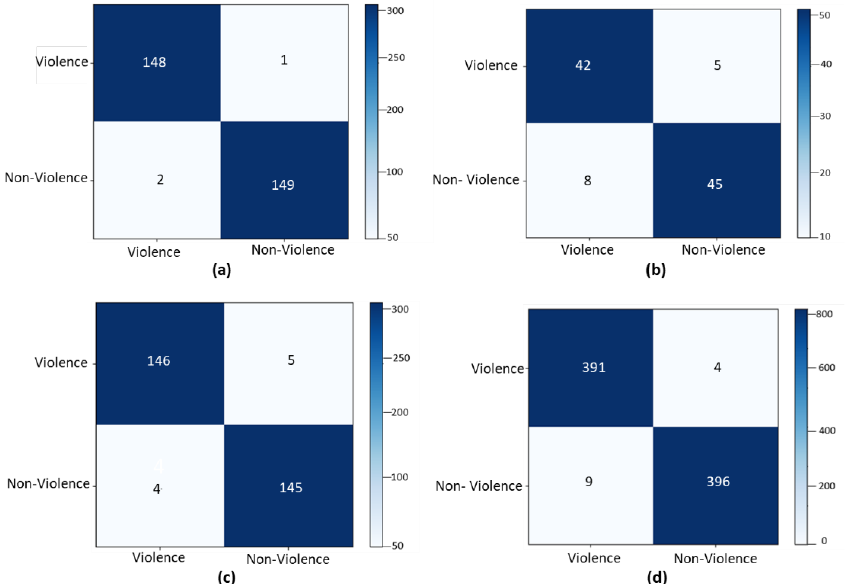
Figure 6. Confusion matrices of the ( a ) Violence in Movies, ( b ) Hockey Fight, ( c ) Violence Scenes Detection datasets, and the ( d ) combined dataset.